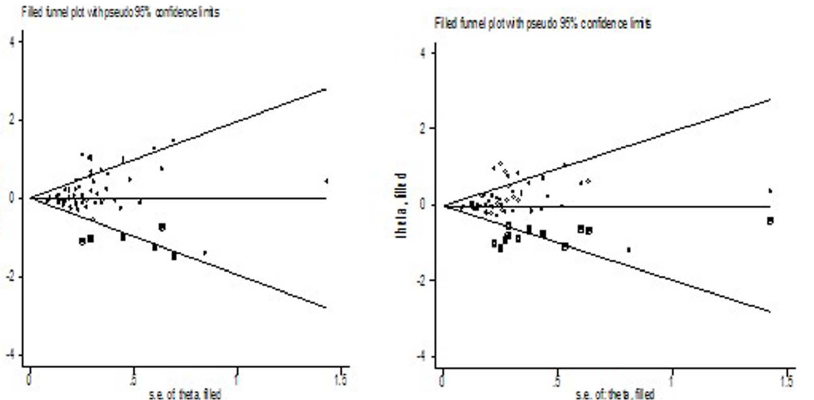
Figure 2. The Duval and Tweedie nonparametric ‘‘trim and fill’’ method’s funnel plot on breast cancer risk (recessive and additive model).